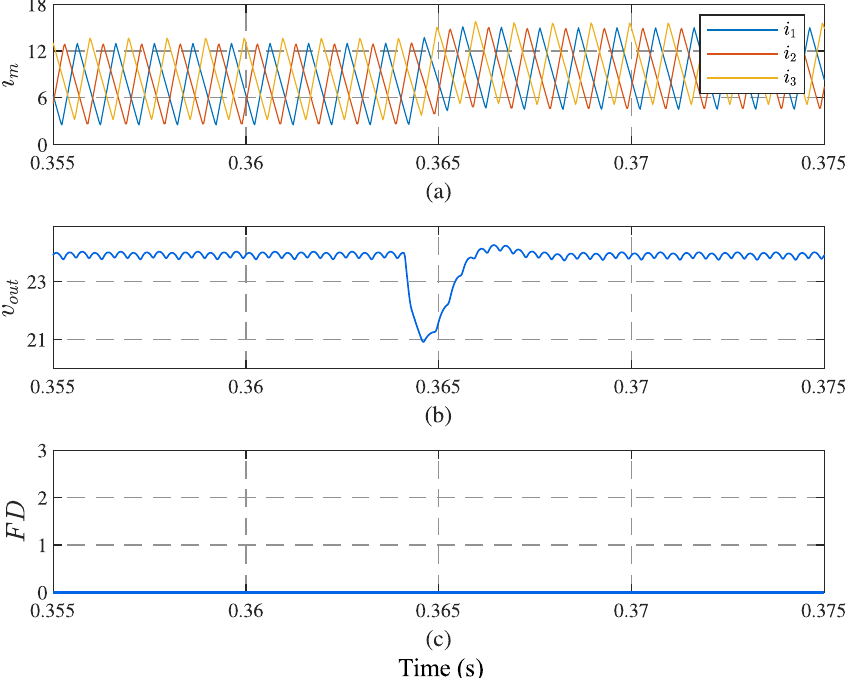
Figure 12. Waveforms when the load resistance R o jumped from 1 to 0.8 Ω at t = 0.3641 s with the proposed method: ( a ) branch 1, branch 2, and branch 3 currents, ( b ) the output voltage at load side, and ( c ) the instantaneous state FD corresponding to an